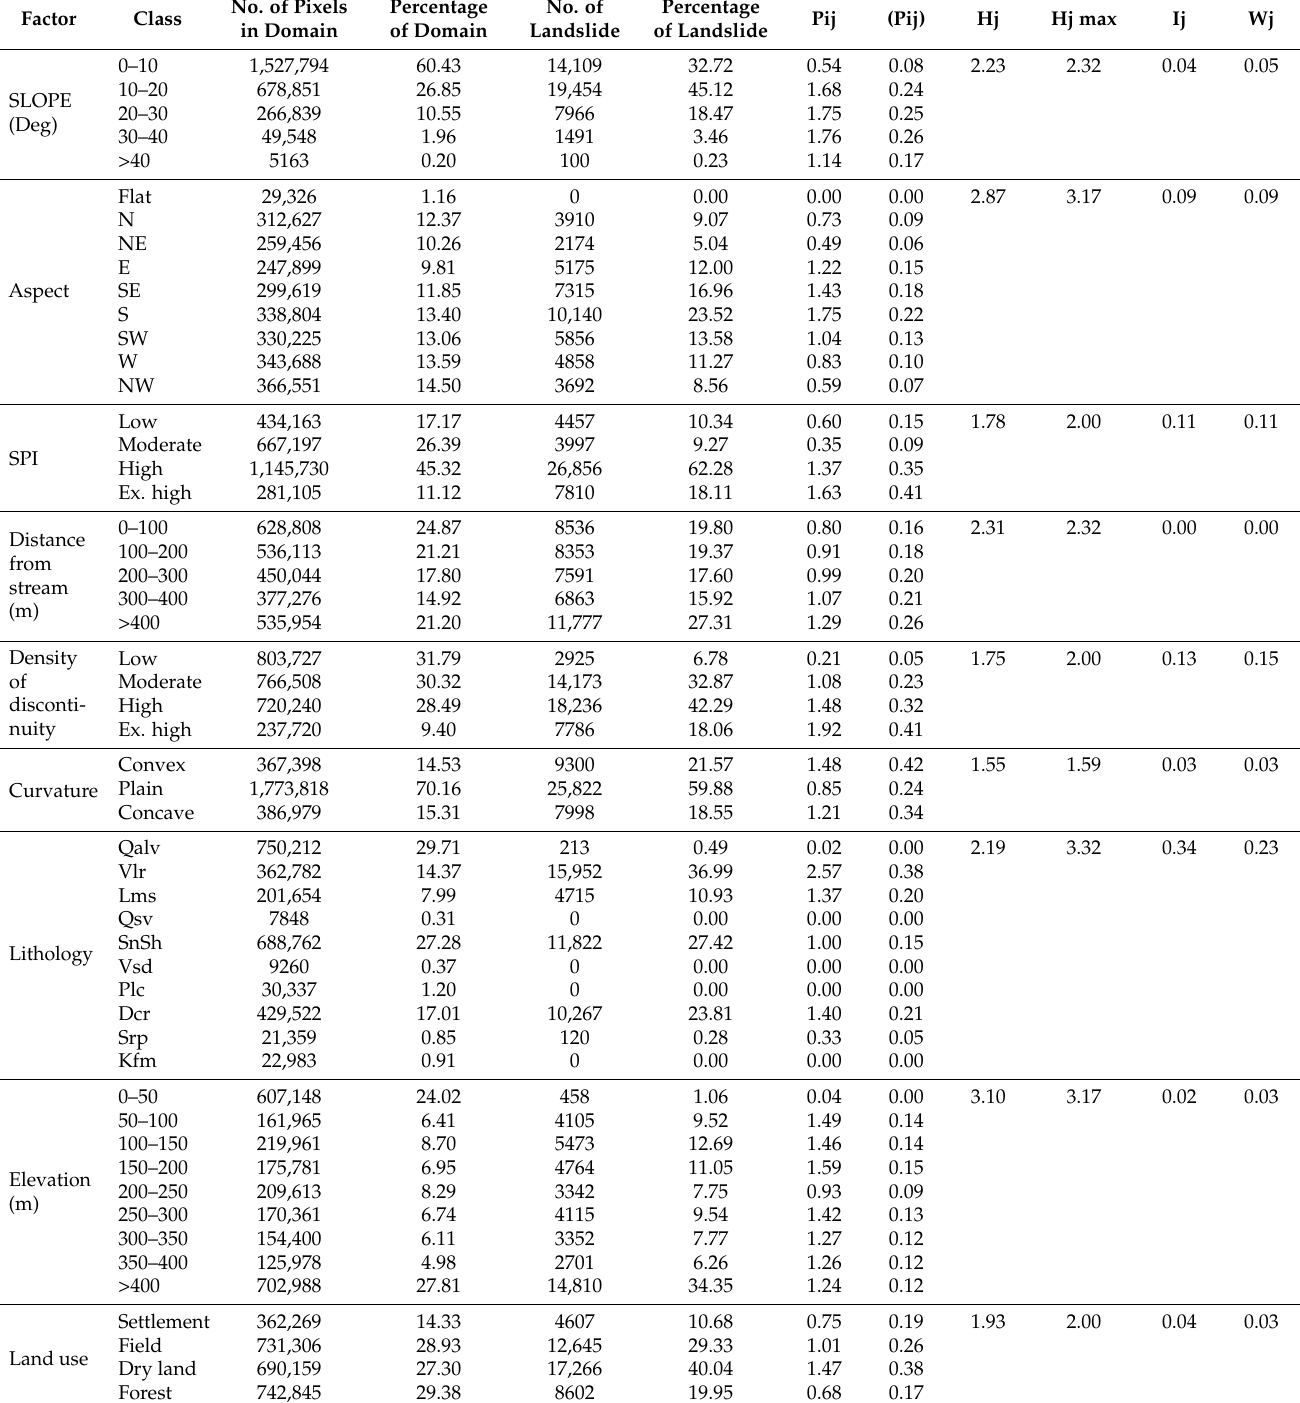
Table 6. IOE values for causative